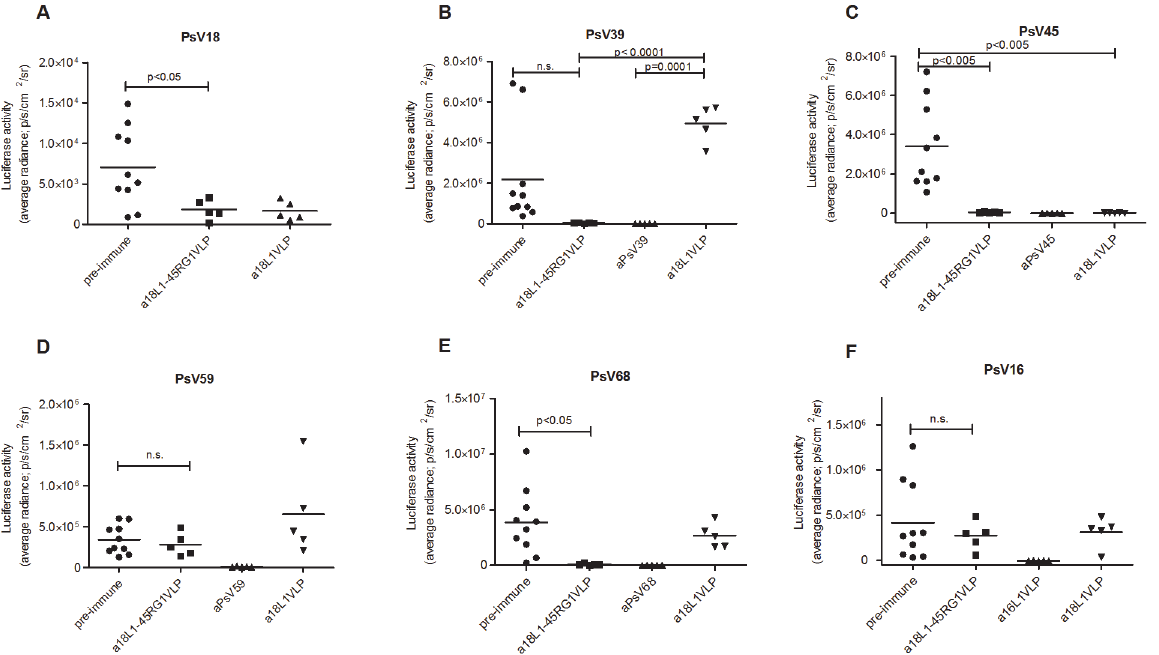
Fig 6. HPV18L1-45RG1 VLP vaccine efficacy against experimental genital challenge with hr α 7 HPV18, 39, 45, 59, 68 pseudovirions in mice. Progesterone synchronized groups of mice were passively immunized by intravenous transfer of 20 μ l of pre-immune or immune sera raised